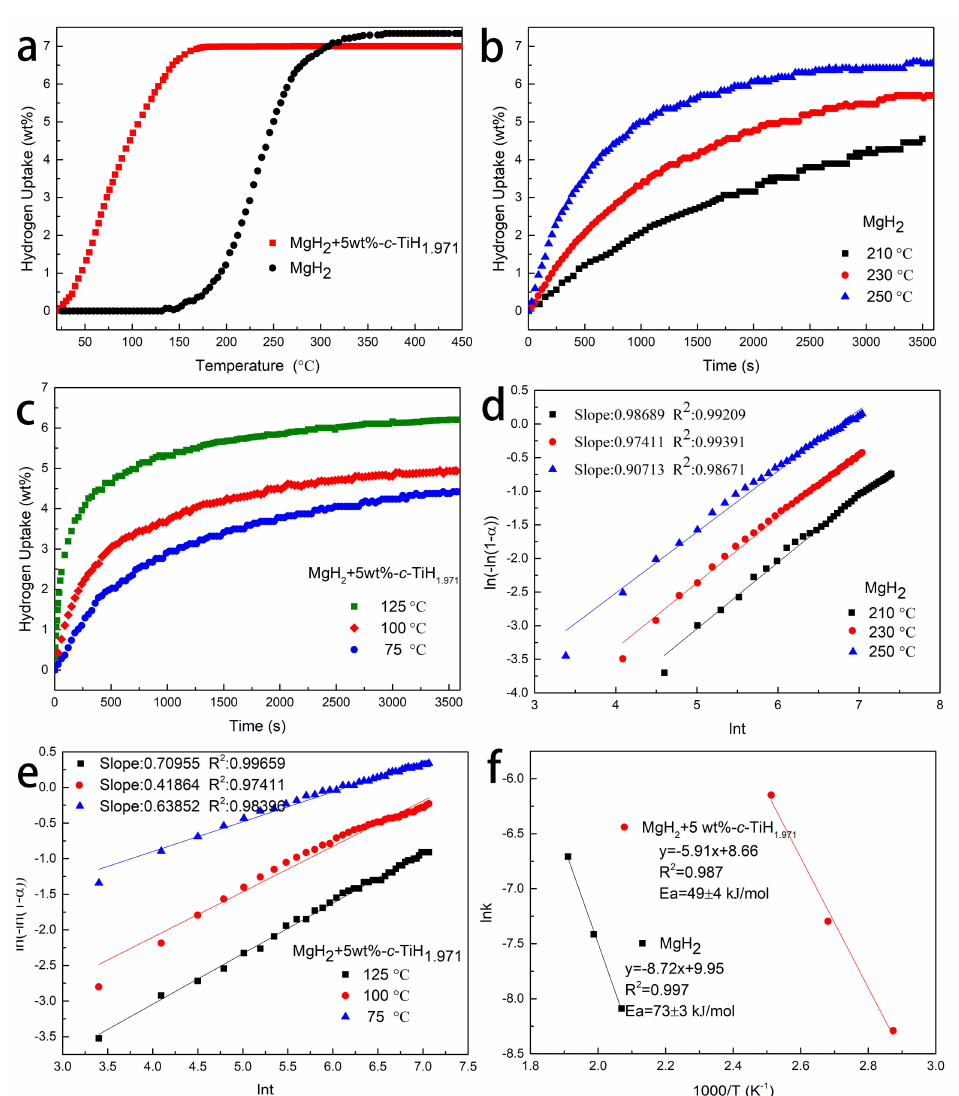
Figure 6. Non-isothermal hydrogenation curves ( a ) of the MgH 2 and MgH 2 + 5 wt%- c -TiH 1.971 samples, isothermal hydrogenation curves of the prepared MgH 2 ( b ), and MgH 2 + 5 wt%- c -TiH 1.971 ( c ) samples at di ff erent temperatures, isothermal hydrogenation JMAK curve plots of the prepared MgH 2 ( d ) and the MgH 2 + 5 wt%- c -TiH 1.971 ( e ) samples, the fitted Arrhenius curve plots ( f ) of MgH 2 and MgH 2 + 5 wt%- c -TiH 1.971